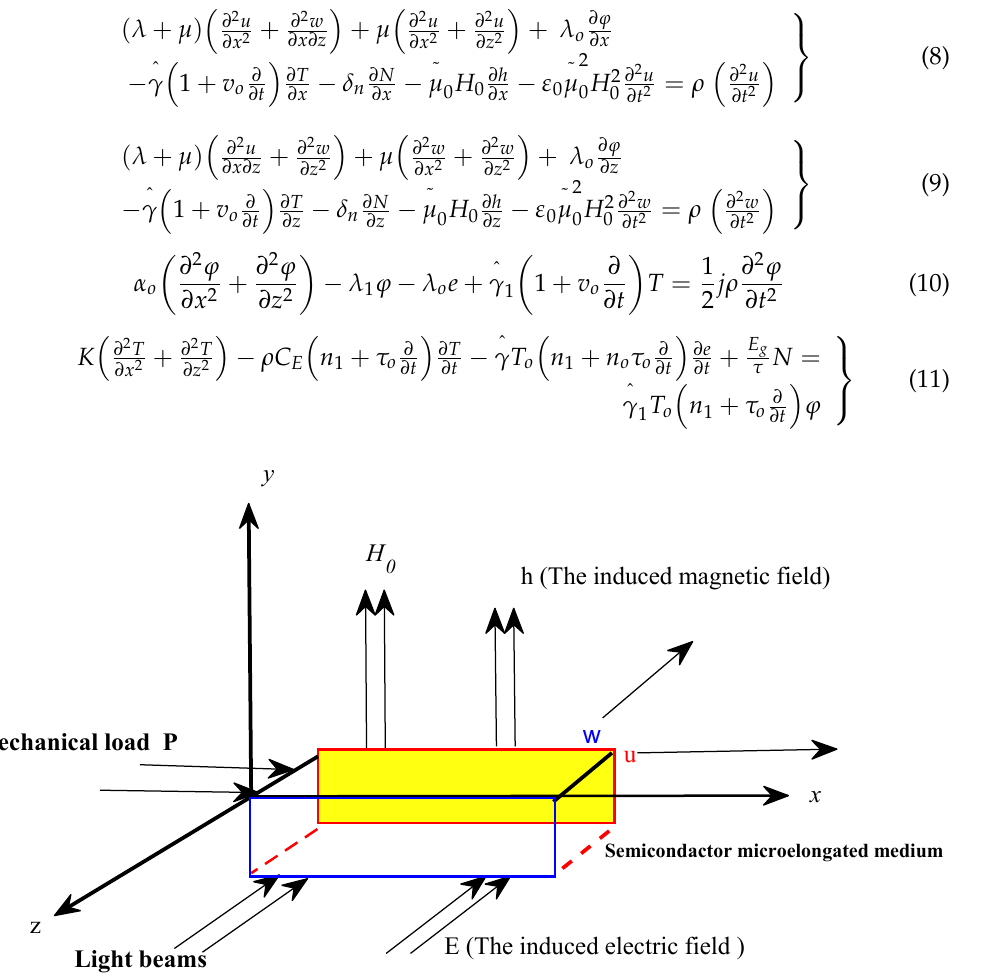
Figure 1. Geometry of the problem.